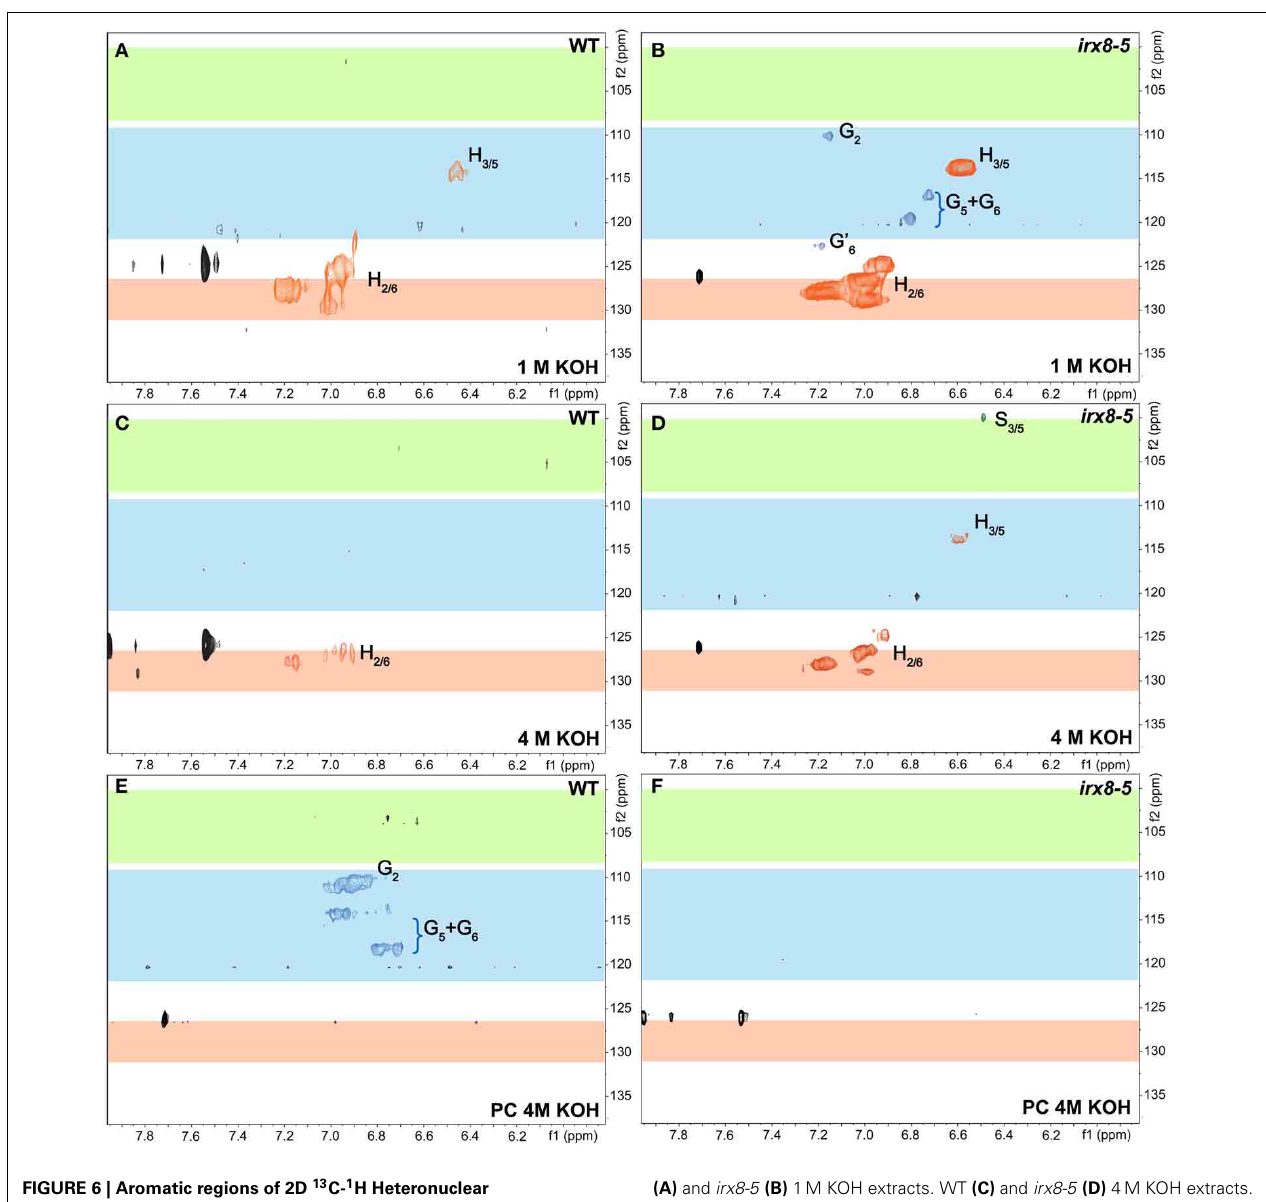
FIGURE 6 | Aromatic regions of 2D 13 C- 1 H Heteronuclear Single-Quantum Correlation (HSQC) NMR spectra of 1M KOH, 4M KOH, and post-chlorite-4M KOH extracts of WT and irx8-5 mutant walls. WT